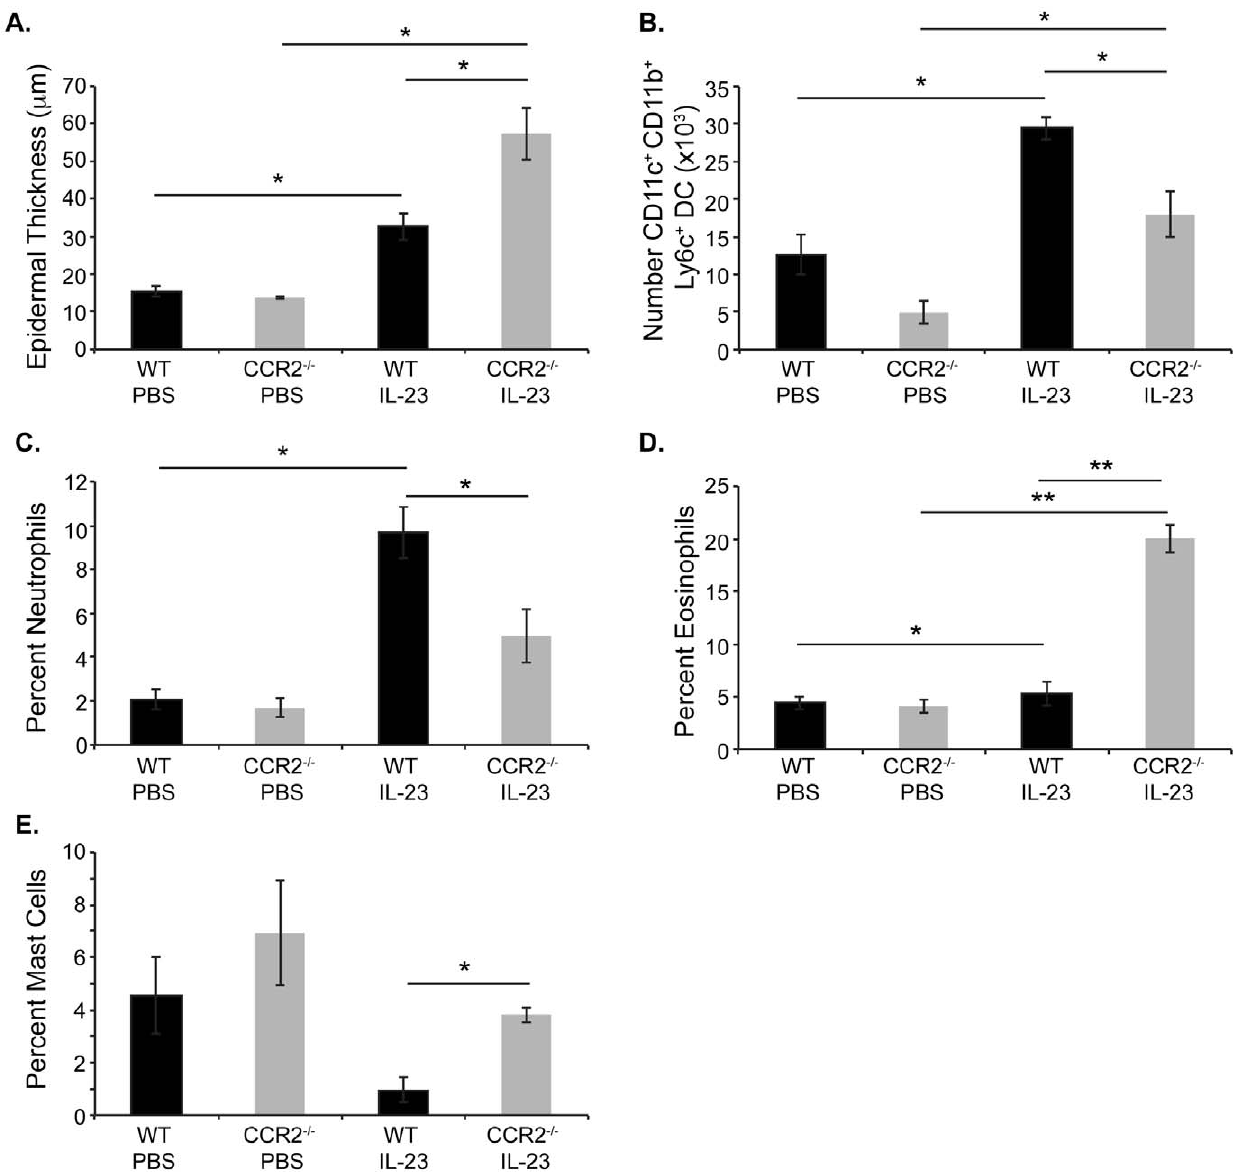
Figure 3. Increased epidermal thickness and accumulation of eosinophils and mast cells in ears of IL-23-injected CCR2 2 / 2 compared to WT mice. (A) Average epidermal thickness was measured on H&E-stained sections. *p , 0.02. Data are from two independent experiments with three-four mice/group. (B) Ears were digested with collagenase and recovered leukocytes were analyzed by flow cytometry to determine numbers of inflammatory dendritic cells (CD11c + CD11b + Ly6c + ) within ears of IL-23 injected WT and CCR2 2 / 2 mice. *p , 0.05. Data are from one experiment with three mice/group. Average percent neutrophils (C) and eosinophils (D) among leukocytes in H&E sections of ears from IL- 23-injected WT and CCR2 2 / 2 mice at day 12. (E) Average percent mast cells among leukocytes in toluidine blue sections of ears from IL-23-injected WT and CCR2 2 / 2 mice at day 12. Slides were imaged (x200, original magnification) and numbers of eosinophils or neutrophils among leukocytes were counted. Data are from four mice/genotype with at least three fields counted per mouse. *p , 0.05; **p ,